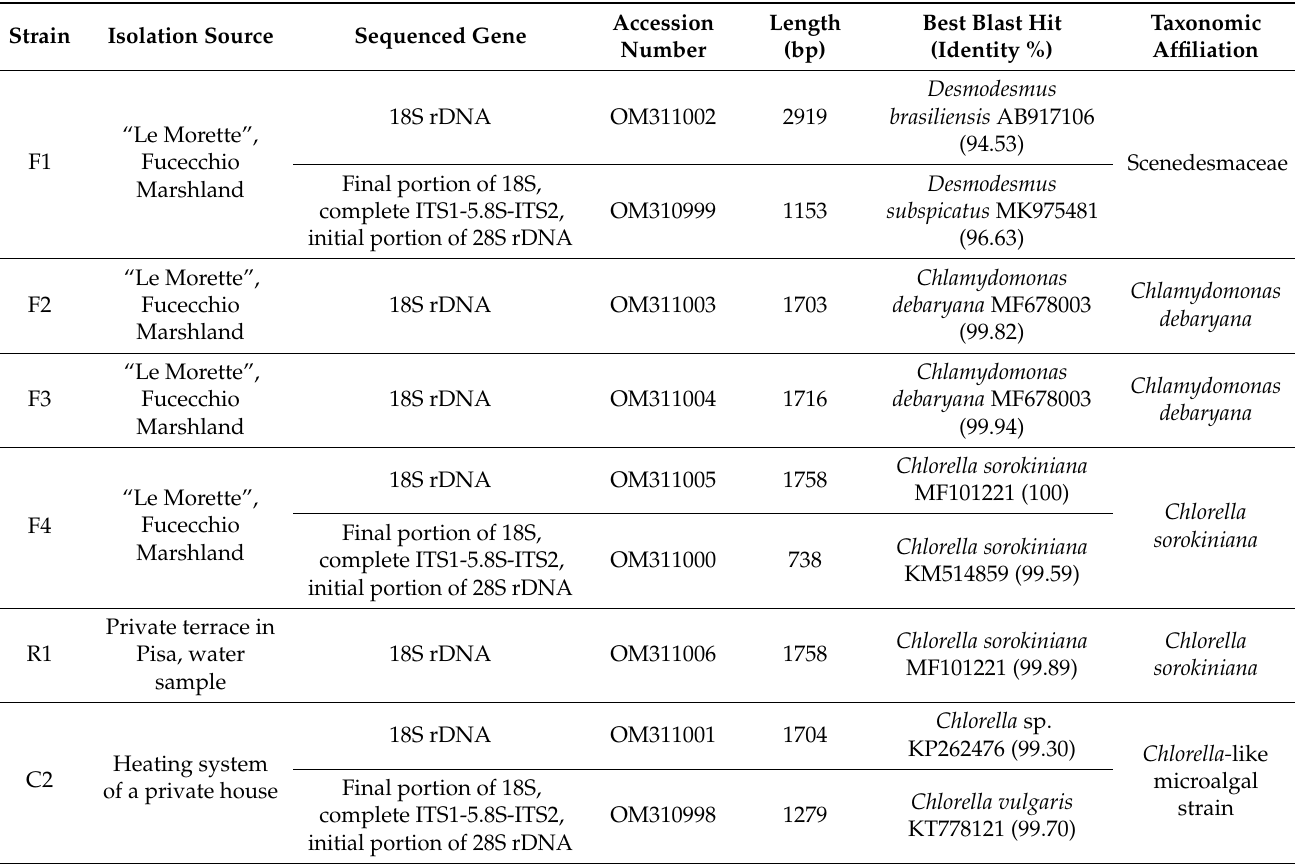
Table 1. Taxonomic affiliation of the six microalgal strains newly isolated from regional freshwa- ter